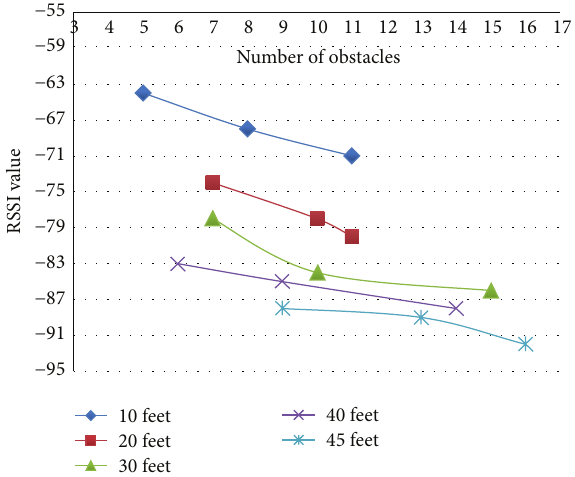
Table 9: Case 5 of experimental setup.